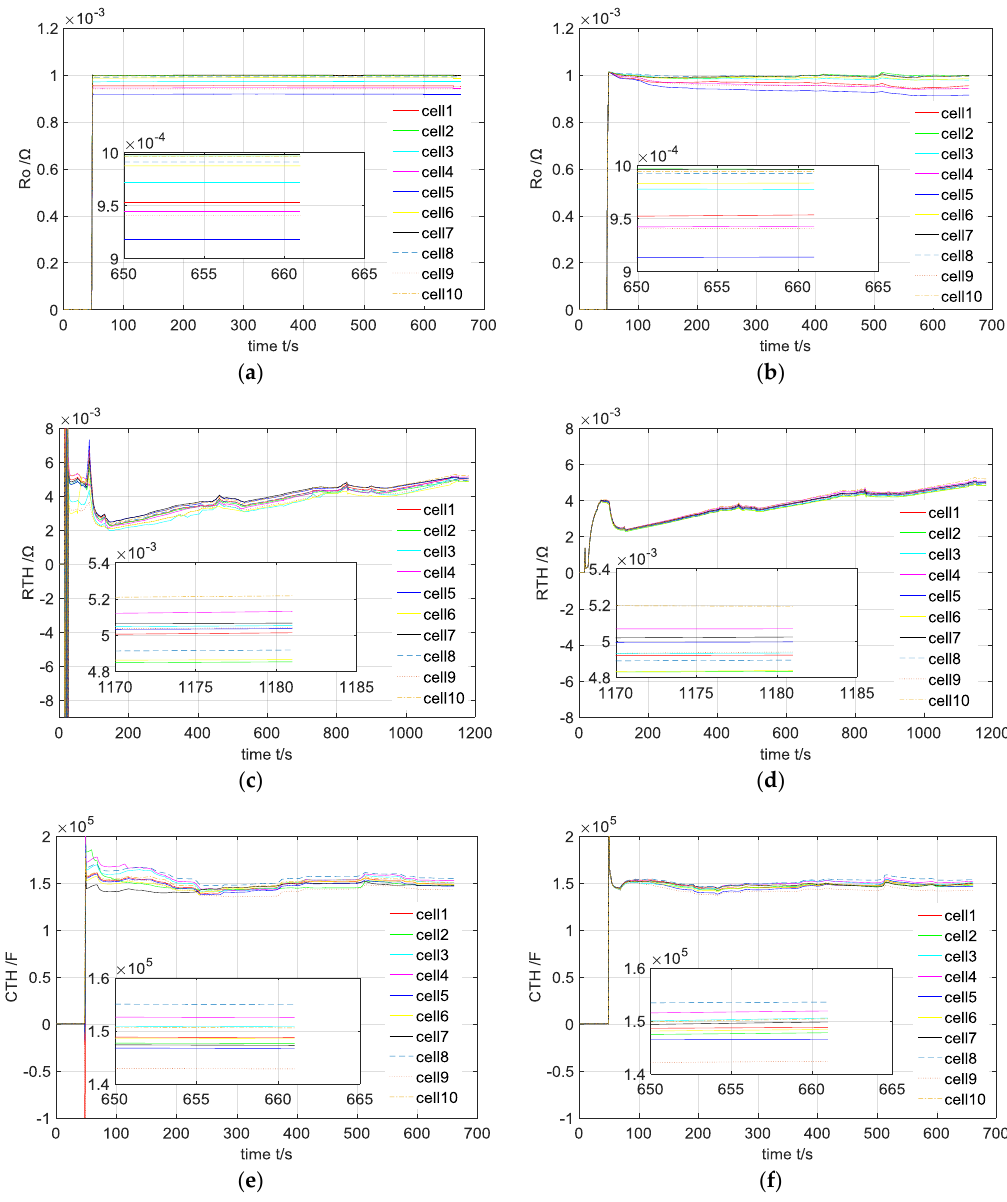
Figure 9. Identified parameters under the NEDC cycle test: ( a ) R O identified by the repetitive recursive least squares (RLS); ( b ) R O identified by the proposed new method; ( c ) R TH identified by the repetitive RLS; ( d ) R TH identified by the proposed new method; ( e ) C TH identified by the repetitive RLS; and ( f ) C TH identified by the proposed new method.